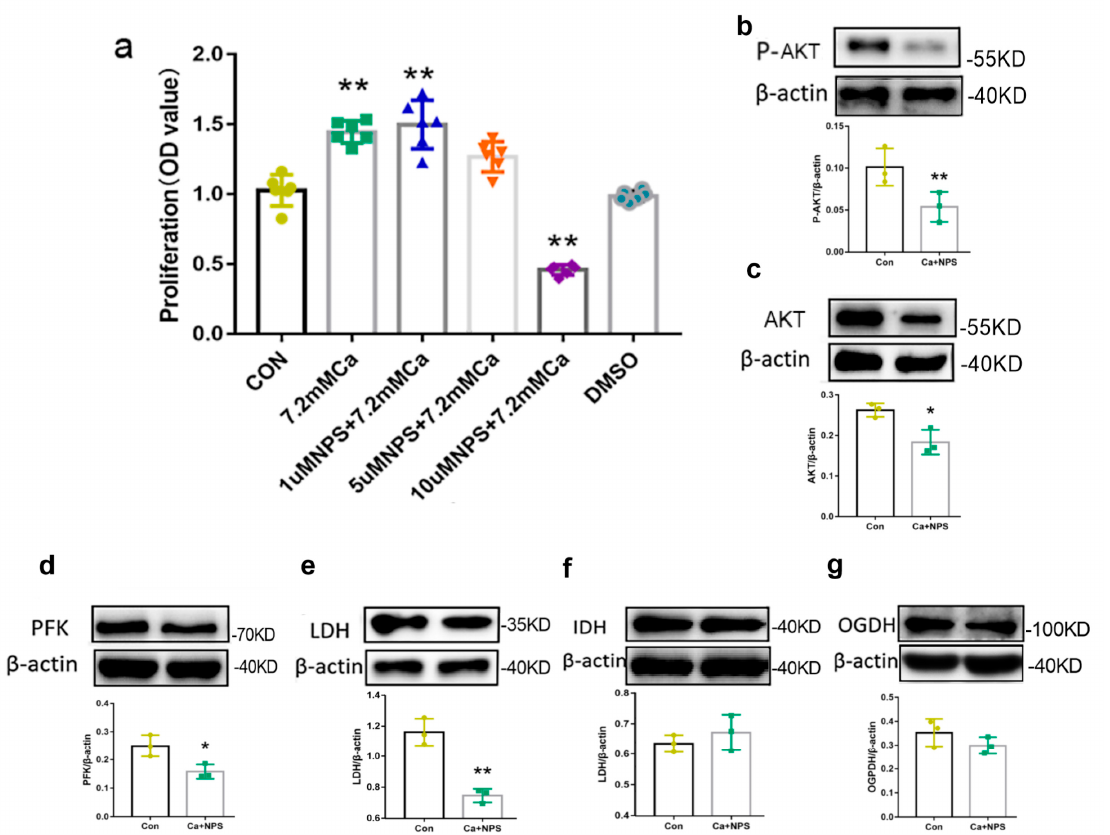
Figure 7. CaSR contributed to cell proliferation through AKT and then glycolic metabolism. ( a ) osteoblasts proliferation treated with extracellular 7.2 mM Ca 2+ and NPS-2143. ( b , c ) changes of P-AKT and AKT induced by extracellular 7.2 mM Ca 2+ and NPS-2143. ( d – g ) changes of OGDH, IDH, PFK and LDH induced by extracellular 7.2 mM Ca 2+ and NPS-2143 * p < 0.05, ** p < 0.01 vs. Con.